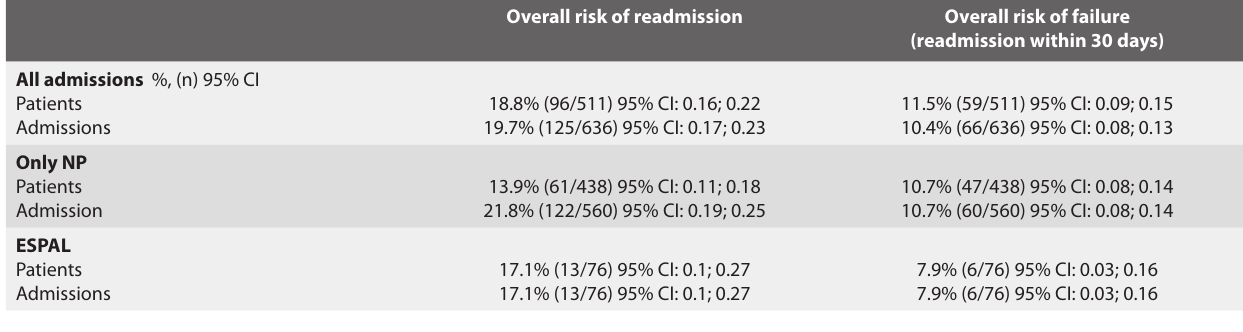
Table 4. Risk of readmission and